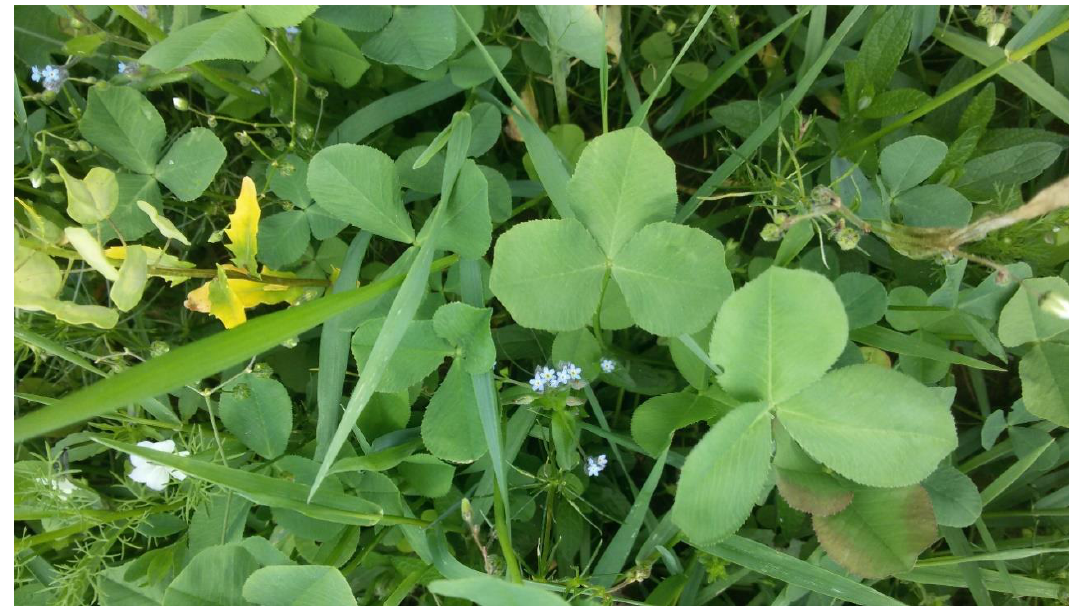
Figure 6. Trifolium resupinatum L. growing on the experimental plot.